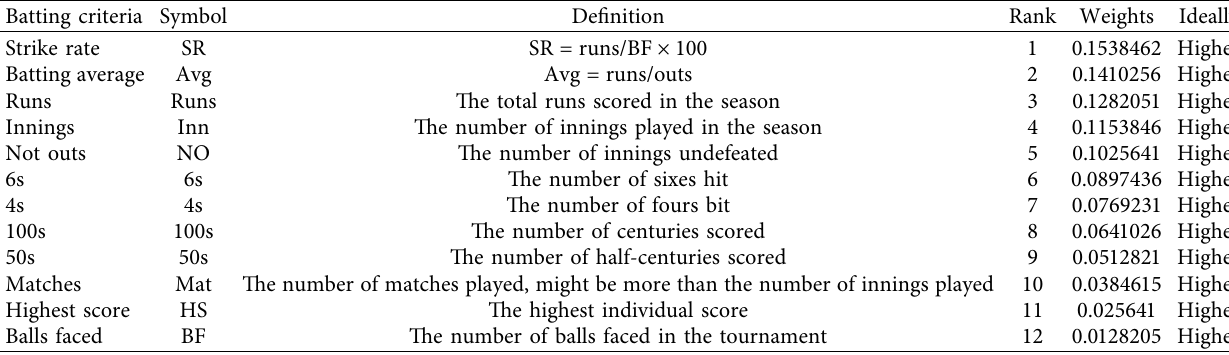
Figure 2: Flowchart of Table 1: Batting performance criteria.